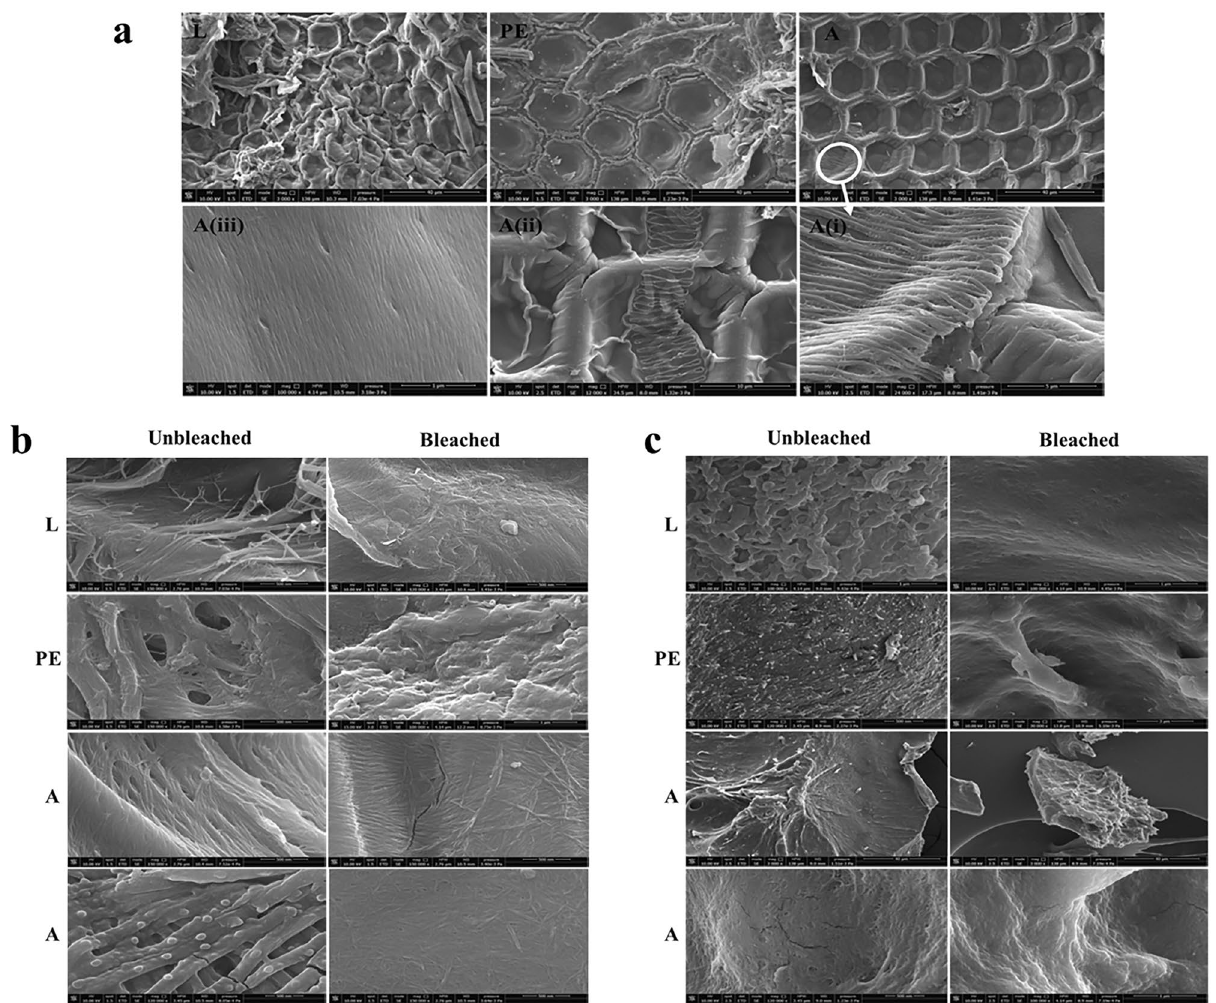
Figure 3. SEM images of (a) honeycomb-like structure of chitin extracted from H. illucens larvae (L), pupal exuviae (PE), with focus on adult chitin (A, Ai, Aii, Aiii). Bars in (L, PE, A):40 µm; bars in (Ai-iii): 5, 10 and 1 µm, respectively (b) Chitin from H. illucens larvae (L), pupal exuviae (PE) and dead adults (A) before (unbleached) and after (bleached) bleaching treatment Bars (L, PE, A): 1 and 500 µm. (c) Chitosan from H. illucens larvae (L), pupal exuviae (PE) and dead adults (A) before (unbleached) and after (bleached) bleaching treatment. Bars in (L): 1 µm; bars in (PE): 500 and 3 µm; bars in (A): 1, 40 and 500